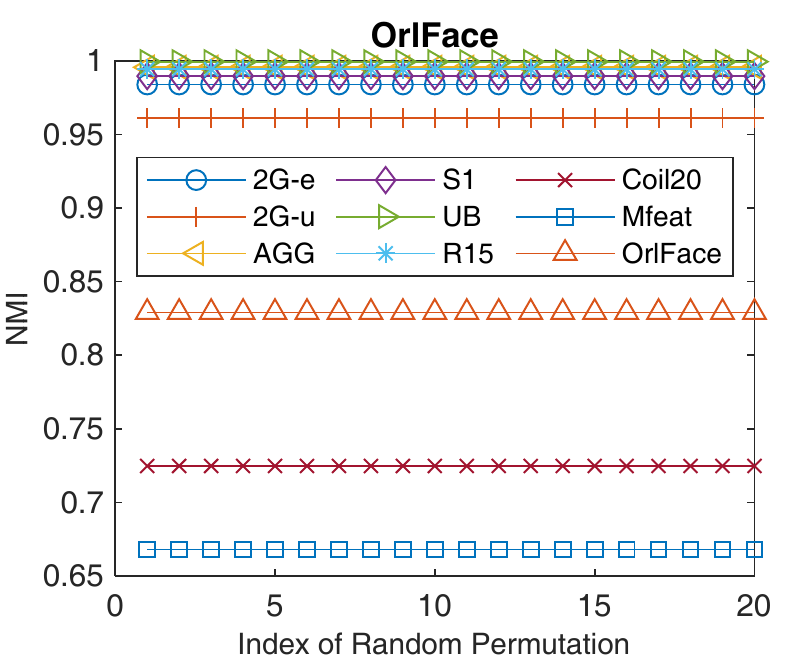
Figure 17. The NMI scores of ND-C(3) on nine datasets. For each dataset, we applied ND-C(3) on it 20 times and each time we randomly permuted the orders of the samples in the